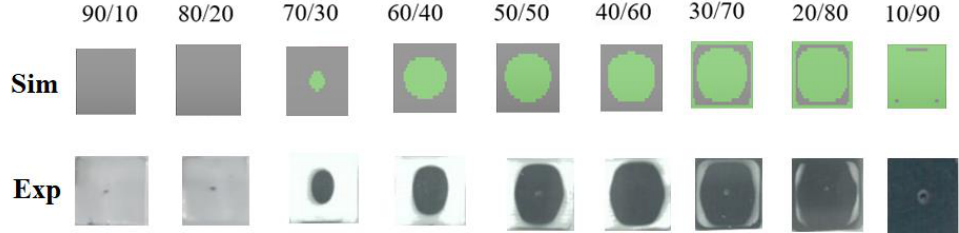
Figure 12. The validation of the cross section of the skin to core with PP/PP arrangement for a skin to core ratio from 90/10 to 10/90.